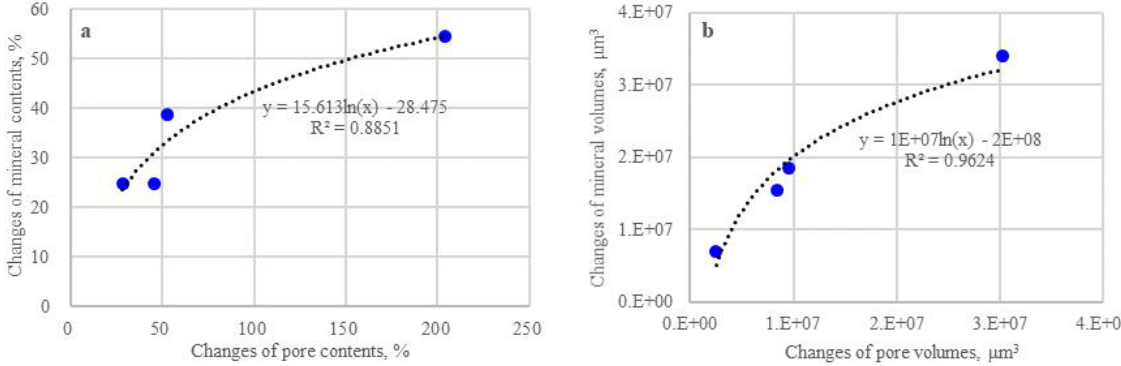
Figure 9—Relationships between pores and minerals before and after CO 2 treatment.